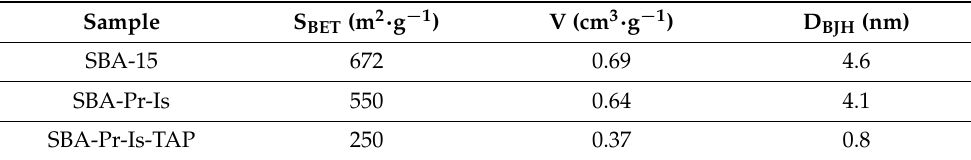
Table 1. Structural parameters of SBA-15, SBA-Pr-Is, and SBA-Pr-Is-TAP. Sample